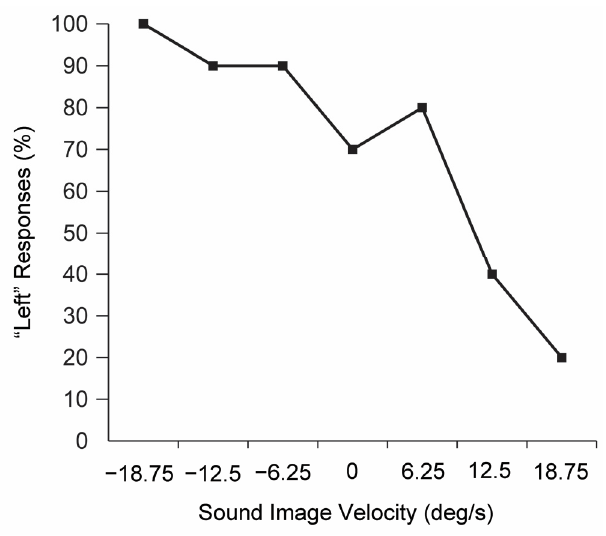
Figure 3. The test of localizing a sound image in the examined patient.